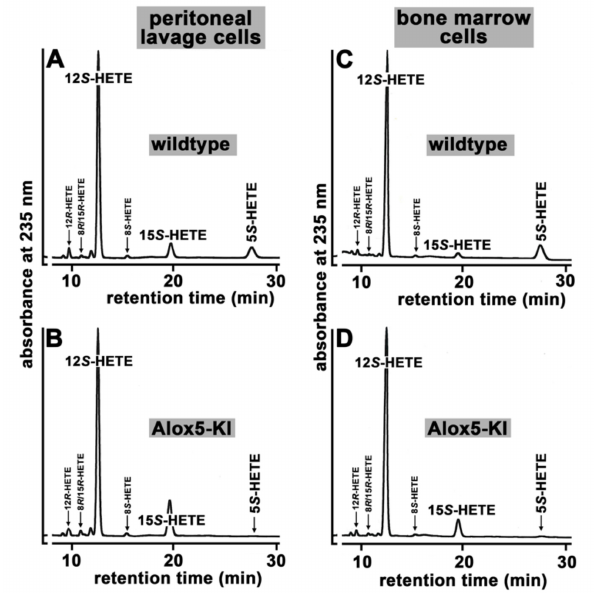
Figure 3. Analysis of the Alox products formed during ex vivo activity assays of peritoneal lavage cells and bone marrow cells of Alox5 -KI and wildtype mice. Cells were prepared and ex vivo activity assays were carried out (see Materials and Methods). The conjugated dienes formed during the 15 min incubation period were prepared by RP-HPLC and further analyzed by NP/CP-HPLC (see Materials and Methods). Each chromatogram was scaled for the 12 S -HETE peak. Four independent individuals ( n = 4) were analyzed for each genotype. Representative partial chromatograms are shown, and statistical evaluation of the product patterns is given in Table 1. ( A ) Wildtype peritoneal lavage cells. ( B ) Peritoneal lavage cells prepared from Alox5 -KI mice. ( C ) Wildtype bone marrow cells. ( D ) Bone marrow cells prepared from Alox5 -KI